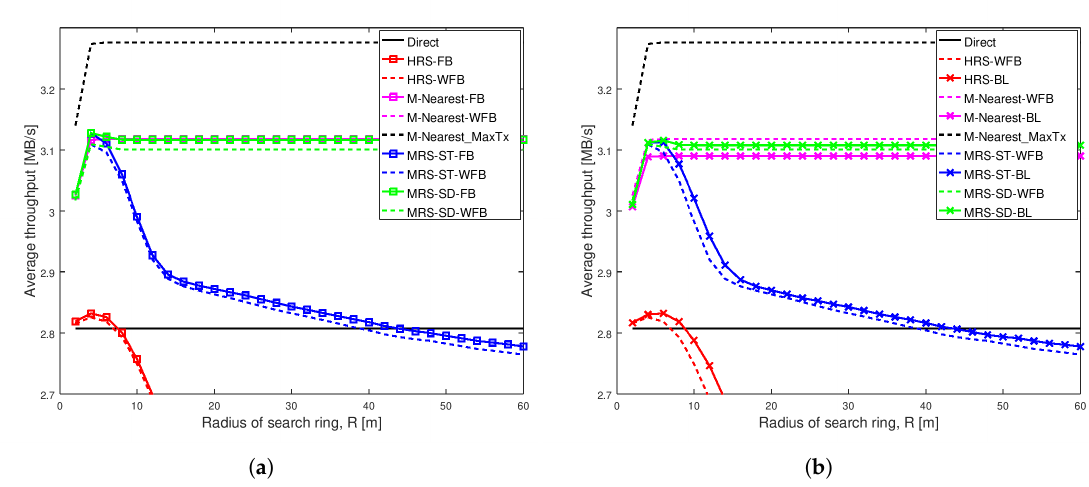
Figure 5. Average throughput of different schemes when Shape = 1.1 and Scale = 0.1 in a network having width of 100 m. ( a ) Different battery power levels not considered in relay selection; ( b ) Different battery power levels considered in relay selection.